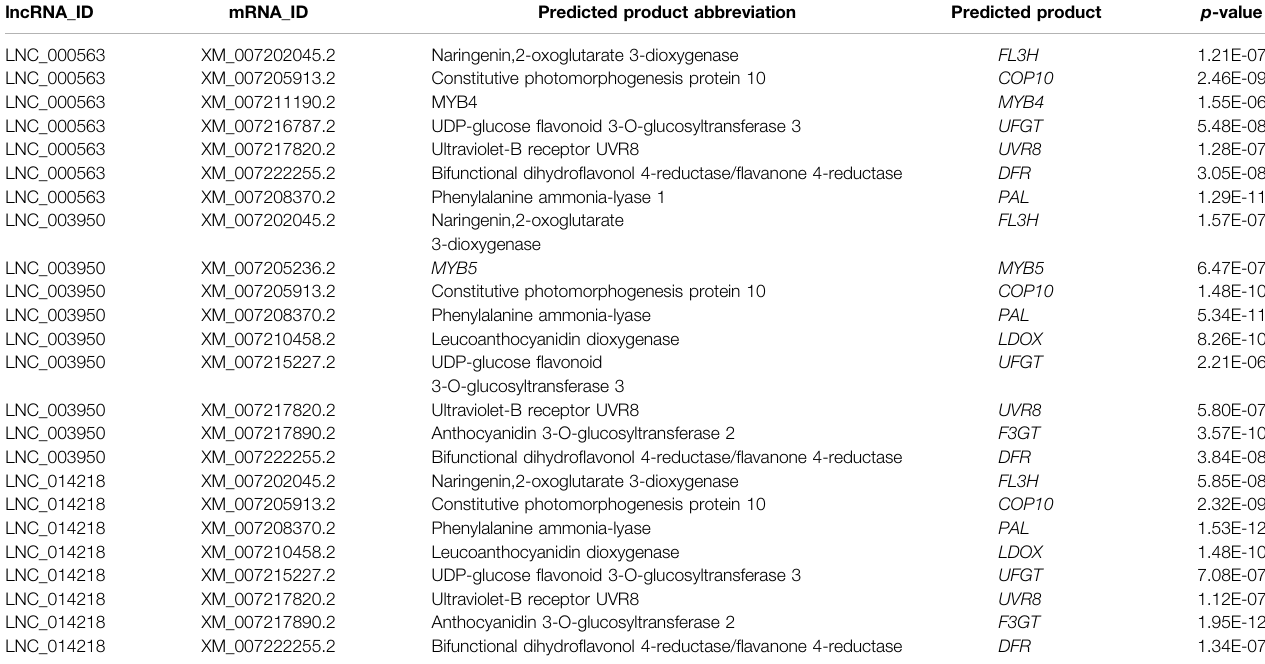
TABLE 2 | XLOC_011933, XLOC_001865, and XLOC_042291 regulate anthocyanin biosynthesis in the fruit development of blood- fl eshed